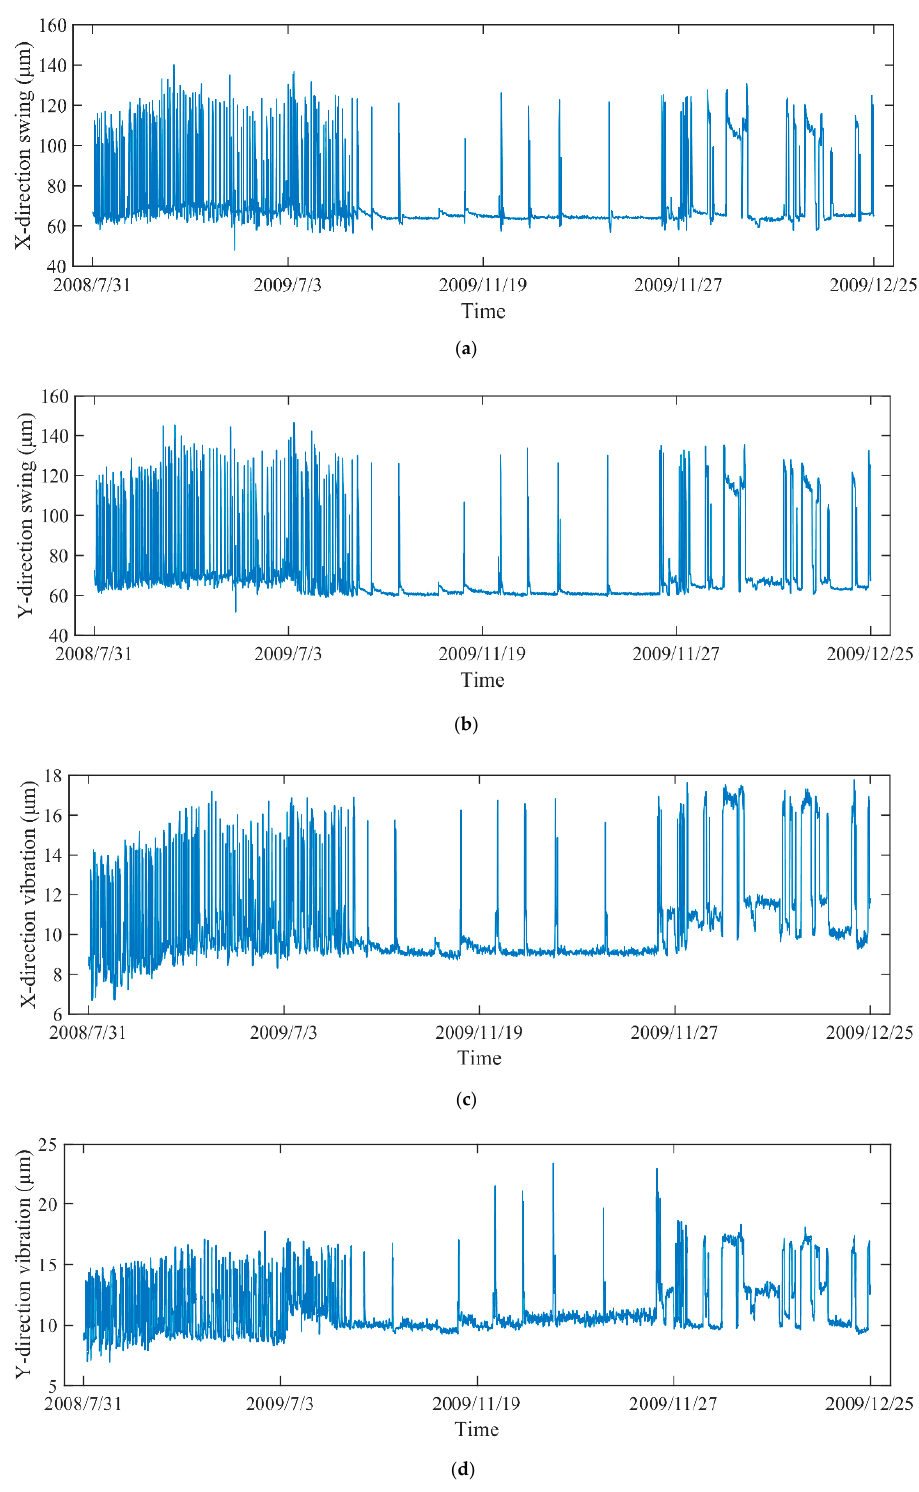
Figure 4. The operation status data of different objects: ( a ) the swing data in X-direction, ( b ) the swing data in Y-direction, ( c ) the vibration data in X-direction, ( d ) the vibration data in Y-direction.